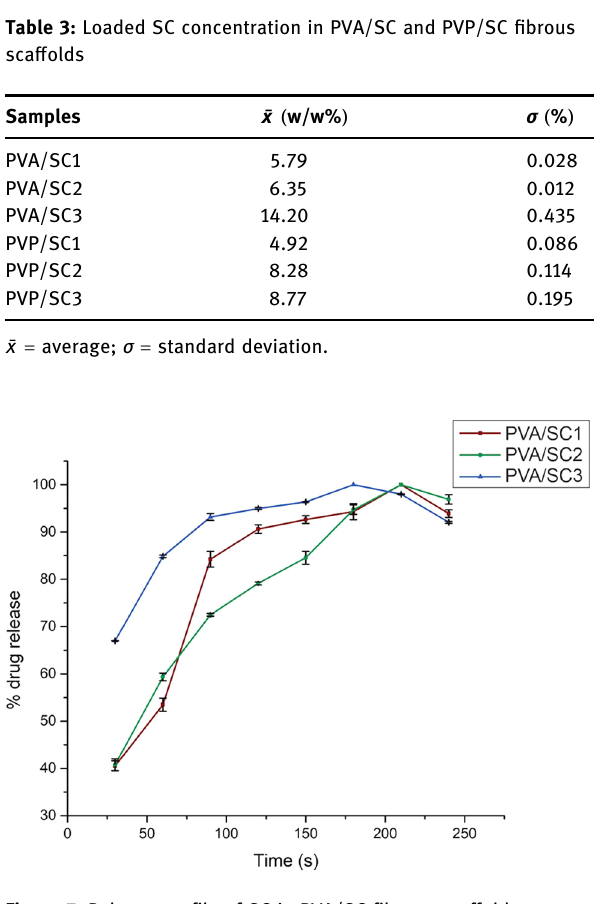
Figure 7: Release pro fi le of SC in PVA/SC fi brous sca ff